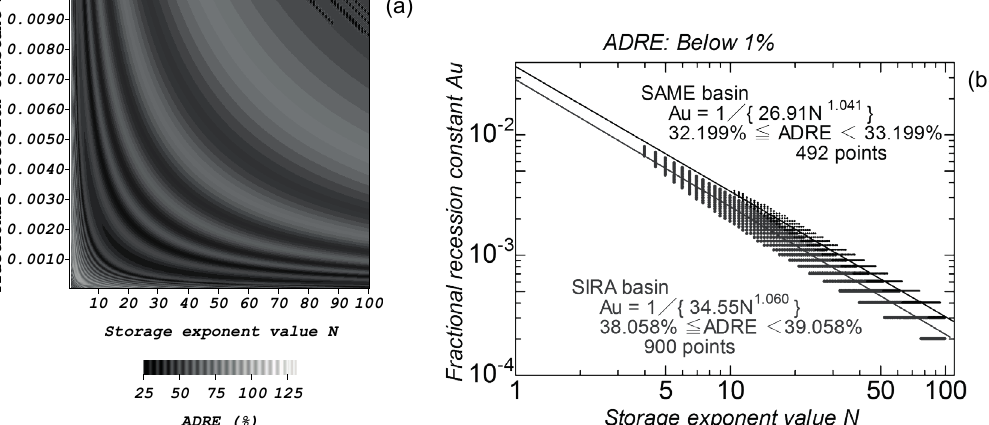
Fig. 4 (a) Visualized ADRE of the SIRA basin and (b) lower 1% values of the ADRE and identified Au - N exponential equations for the two